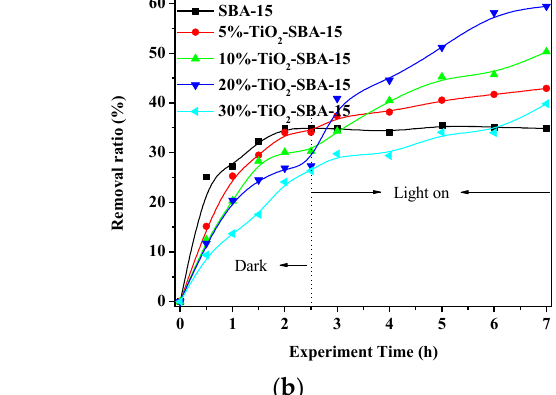
( b ) Figure 9. ( a ) The photocatalytic performance curve of 20%-TiO 2 -SBA-15 samples before and after hydrothermal treatment, ( b ) The photocatalytic performance of 20%-TiO 2 -SBA-15 and 20%-P25- SBA-15. According to these characterizations and photocatalytic performance, TiO 2 -SBA-15 enhances adsorption and photocatalytic performance, because the enhanced absorption improves the concentration, as well as the collision likelihood of hydroxyl radicals and pollutants. As Figure 10 shows, TiO 2 -SBA-15 adsorbs toluene and increases the molecule amount in the inner channel. The hydroxyl radicals are produced under UV light irradia- tion on TiO 2 -SBA-15, which collides efficiently with the toluene inside the pore, then re- leases the produced CO 2 and H 2 O.